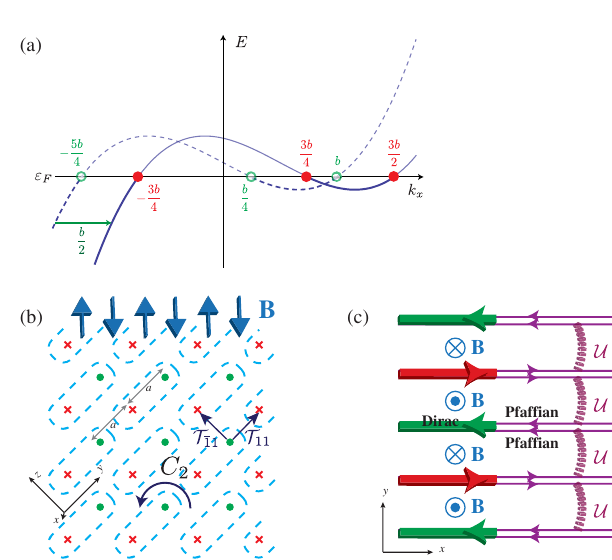
k with (solid curve) y ¼ 2 l ð x Þ